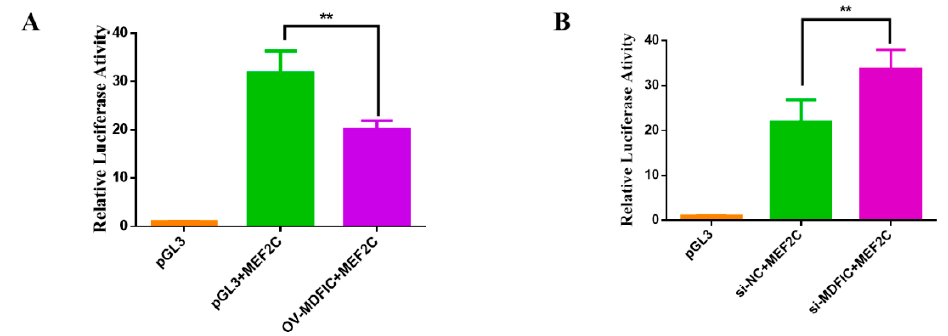
Figure 7. MDFIC regulate the transcription activity of MEF2C . ( A , B ) Luciferase assay was conducted by co-transfecting MEF2C promoter region and OV-MDFIC or si-MDFIC with TK-Renilla plasmid. Results are representative of the mean ( ± SD) of three independent analyses. ** p < 0.01.